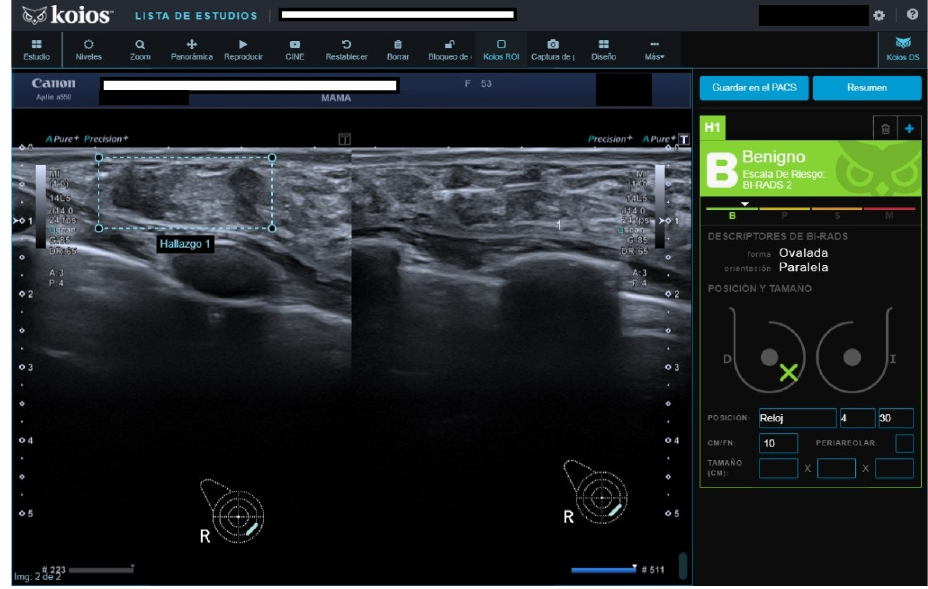
Figure 6. Palpable nodule rated B4b on BUS, Kbe by KOIOS. Confirmed invasive carcinoma. The results of B3+B4a+B4b revealed 264 biopsies for 73 malignancies (27.7%), whereas Kpb+KSS rendered 220 biopsies for 96 malignant diagnoses (43.6%).